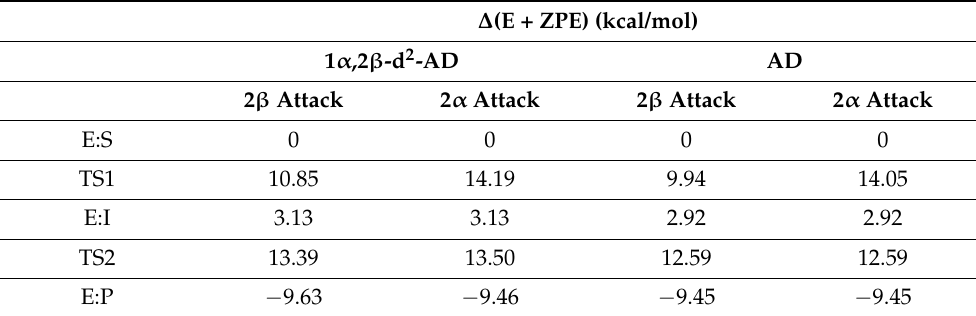
Table 1. Results of the QM:MM modelling of 1,2-dehydrogenations. The ∆ (E + ZPE) energies were provided in kcal/mol for 1 α ,2 β -deuterated AD and non-labelled